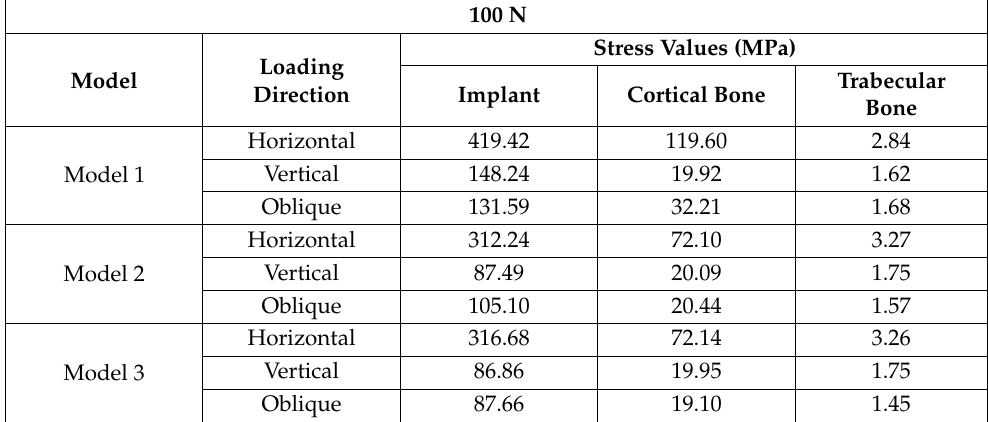
Table 3. The Von Mises stress values on implants, cortical bone and trabecular bone after the application of 100 N static load.